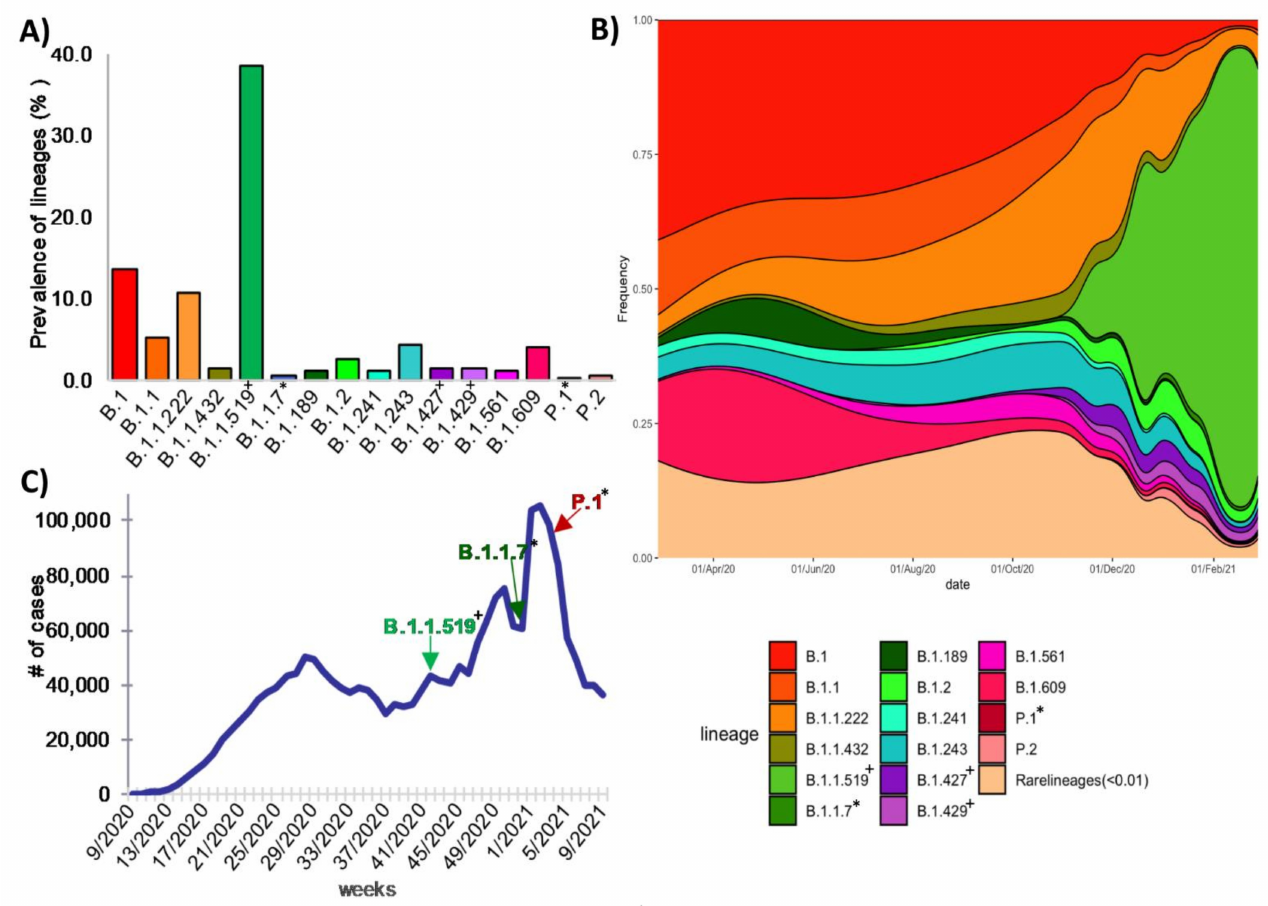
Figure 4. Circulation of SARS-CoV-2 lineages in Mexico during the first year of the pandemic. ( A ) Most frequent lineages. ( B ) Temporal distribution of lineages in Mexico between February 2020 and February 2021. ( C ) First detection of the B.1.1.519 lineage in the context of the COVID-19 epidemic curve, as well as Alpha (B.1.1.7) and Gamma (P.1) variants. * Variants of concern (VOCs): B.1.1.7 and P.1. + Variants under monitoring: B.1.1.9, B.1.427 and